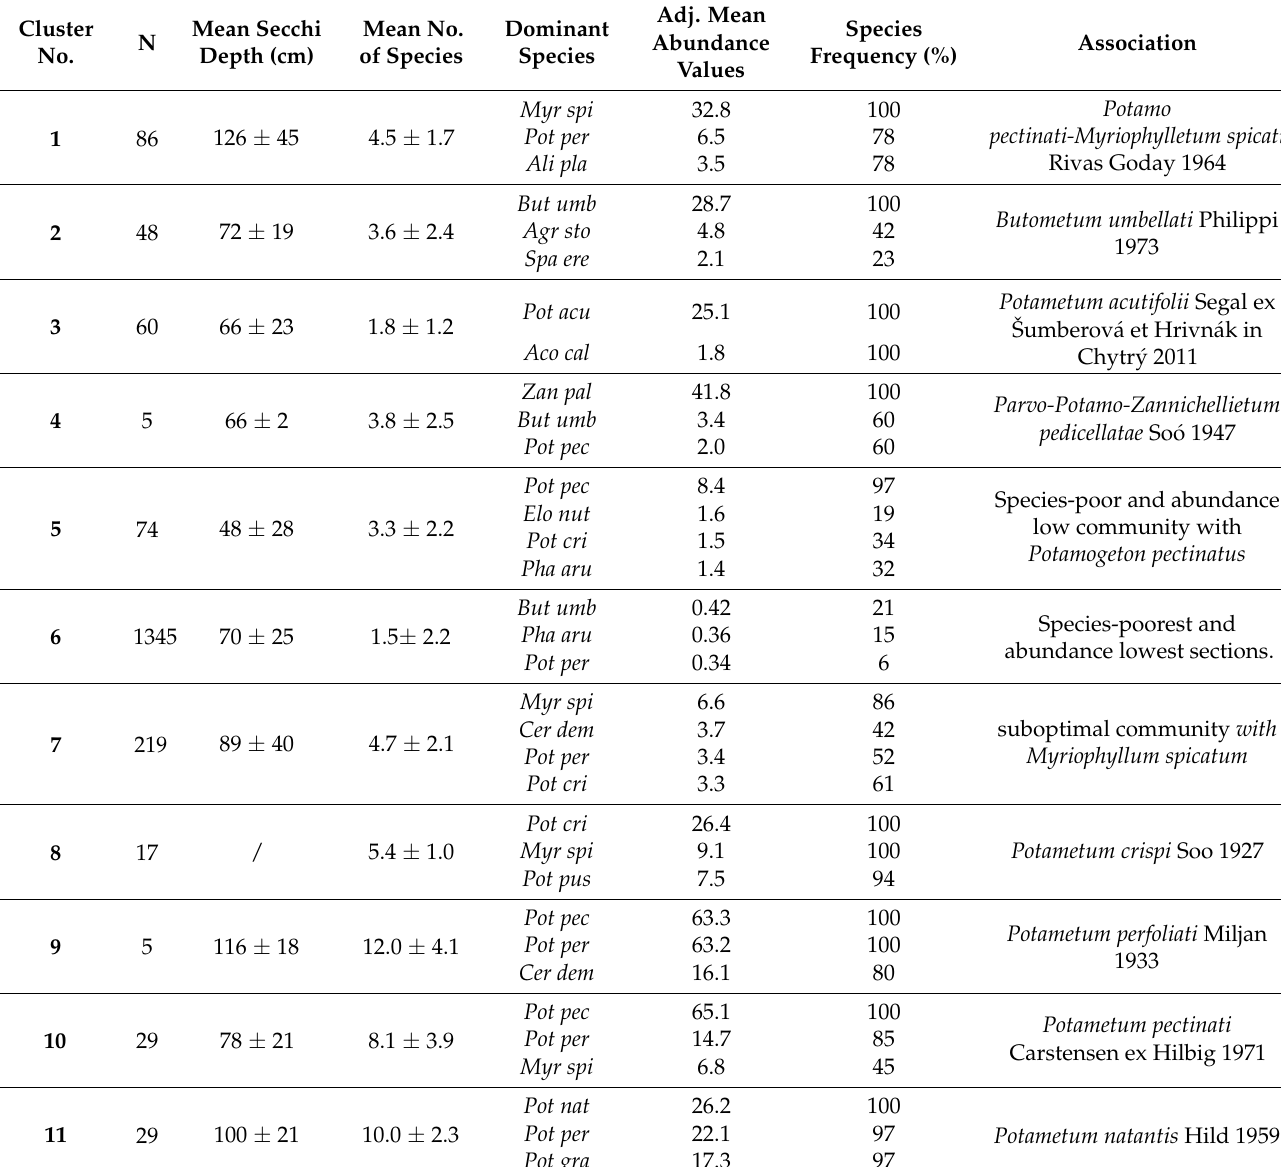
Table 1. The description of different clusters regarding the number of stretches/plant assemblages (N) mean Secchi depth, mean number of species, dominant species, adjusted mean abundance of dominant species, species frequency and the type of